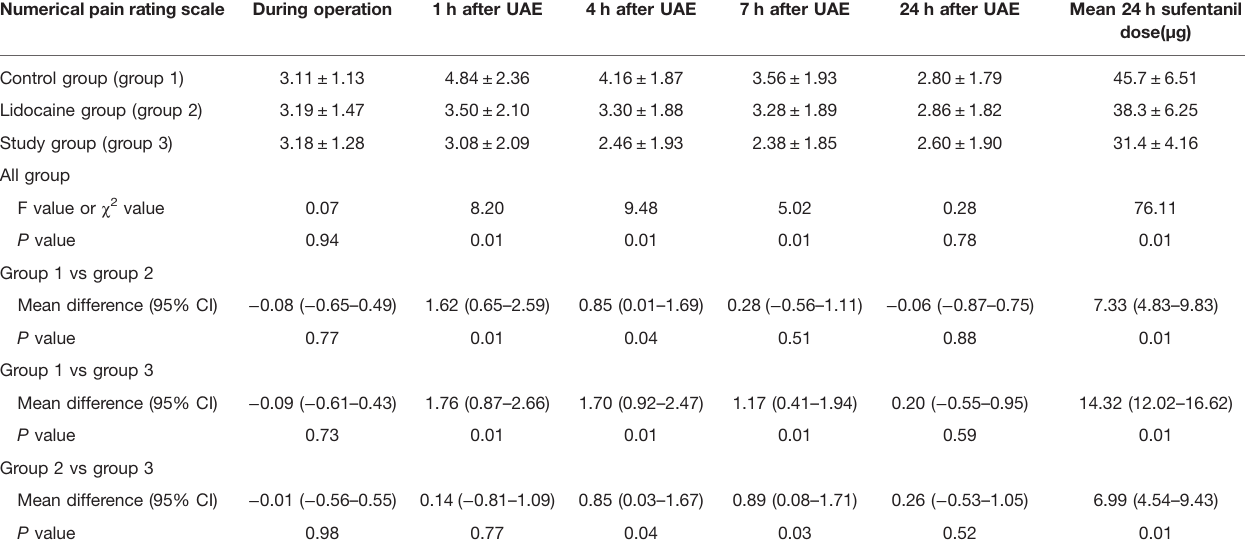
TABLE 4 | Comparison of pain scores at different times and 24-hour sufentanil use among the three groups in patients with uterine artery embolism. Numerical pain rating